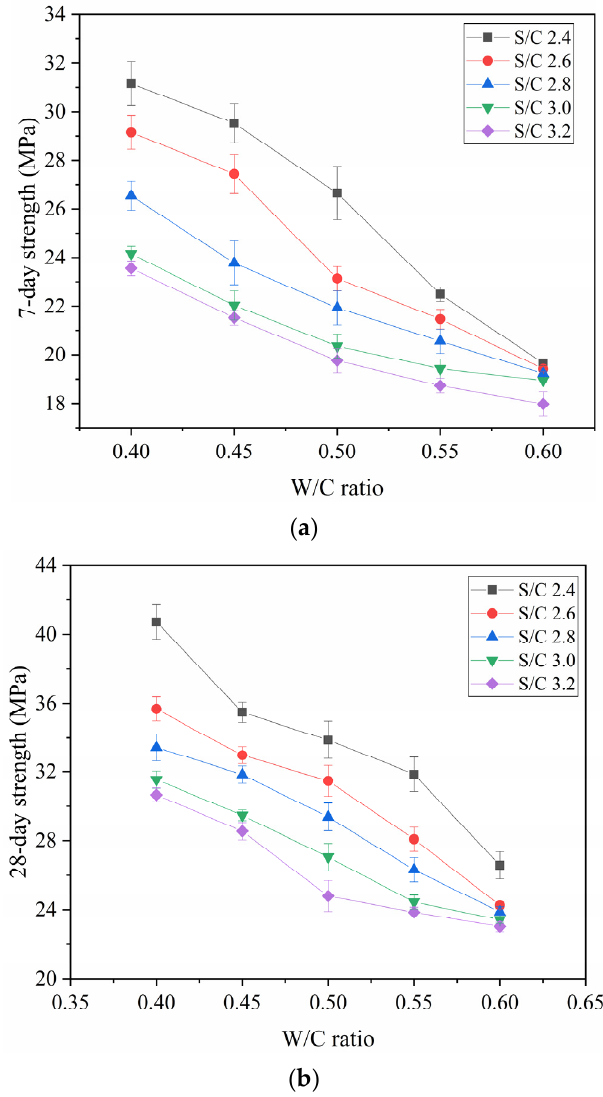
Figure 7. Strength versus W/C Ratio: ( a ) 7-Day Strength, ( b ) 28-Day Strength. To explain how the PCE dosage affects strength, the correlation between the strength and PCE dosage for five different W/C ratios was plotted as a curve. This is illustrated in Figure 8. Under the condition of 7 days of curing of the mortar specimens, when the